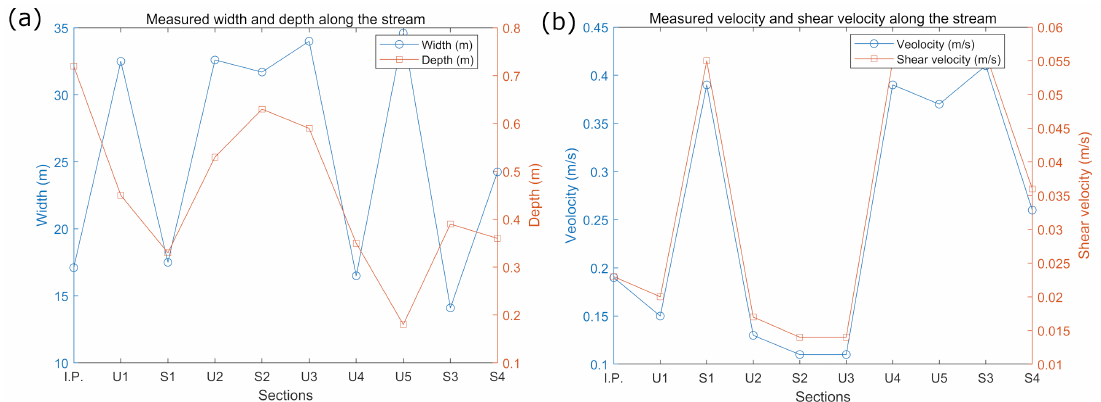
Figure 14. Plots of measured hydraulic data in Cheong-mi Creek; ( a ) Width and depth; ( b ) Velocity and shear